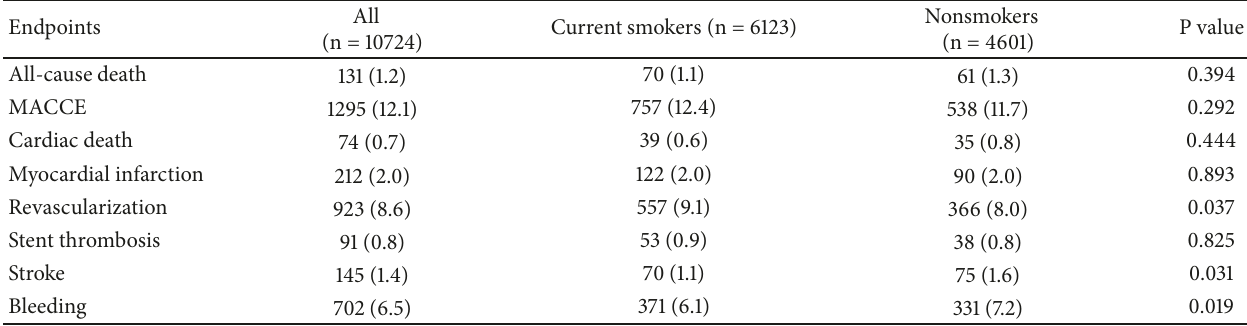
Subgroups included male or female subgroups, patients with age ≥ 75 or < 75, patients diagnosed with STEMI, NSTEMI, UAP, or SCAD, patients with TVD or LM involved, patients with high, intermediate, or low SS, and patients who underwent CR or ICR. The interaction analysis showed clas- sification of CAD was not independent of baseline smoking status ( P =0.038). COX regressions analysis showed that, in all subgroups except for TVD subgroup, current smokers, compared with nonsmokers, were also not independently associated with MACCE (all P > 0.05). In patients with